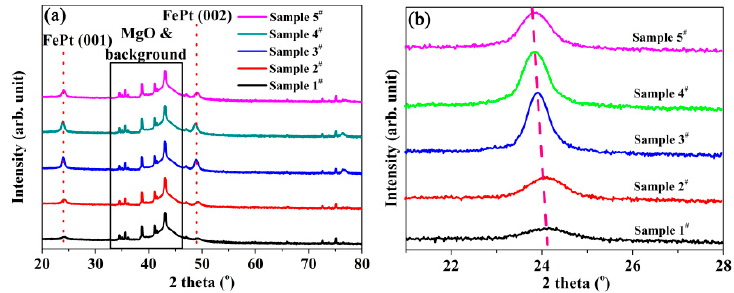
Figure 2. ( a ) The XRD patterns of FePt/MgO nanocomposite films; ( b ) an expanded view of peak (001) of FePt.